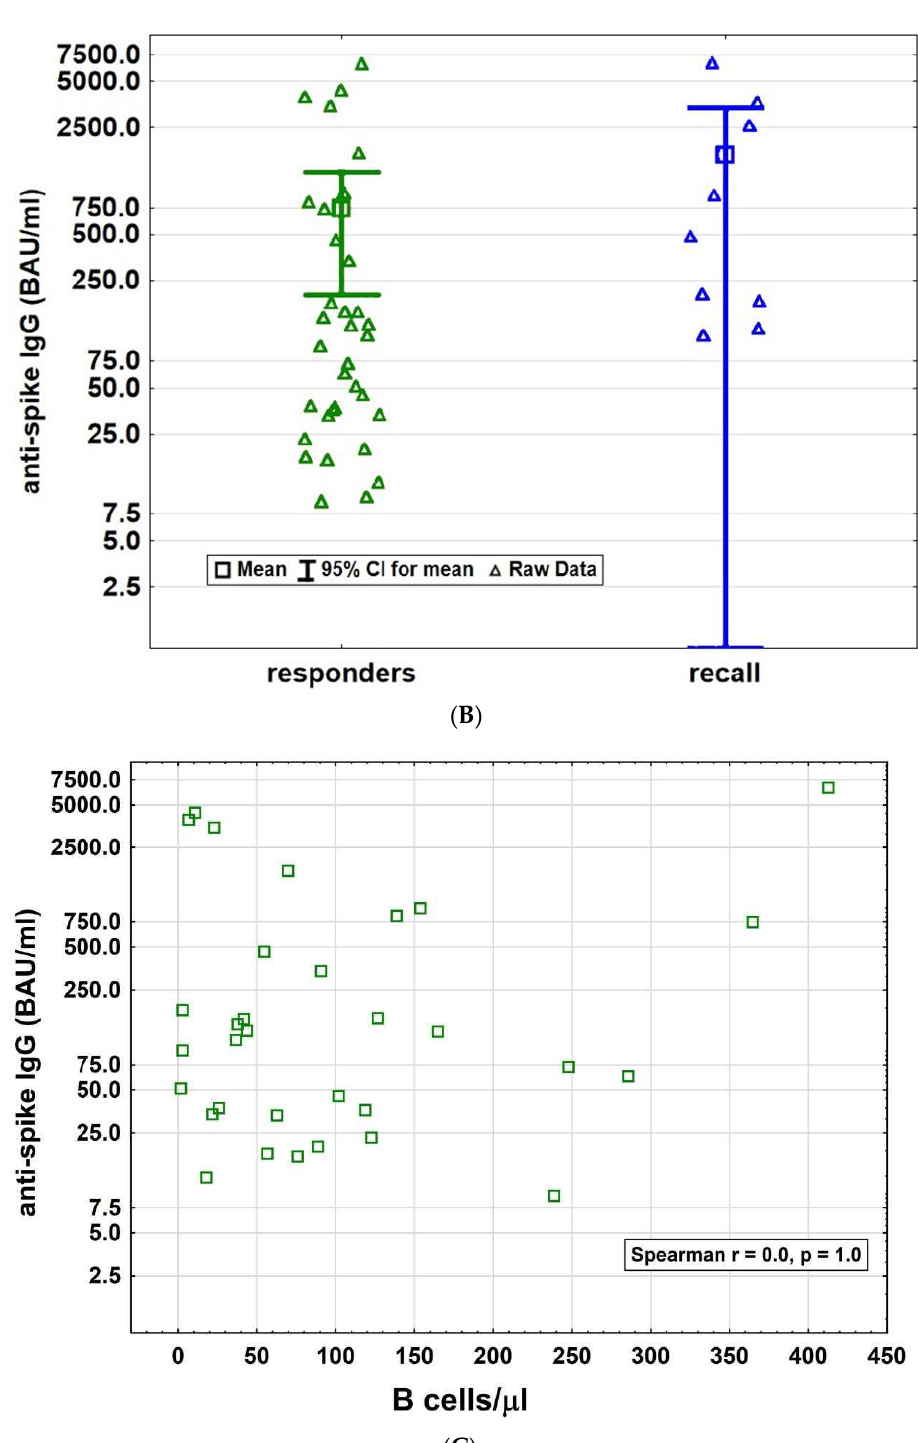
Figure 1. ( A ) Peripheral B-cell counts among all three patient groups at the time of anti-spike IgG assessment. B-cell numbers are highest in the responder cohort compared to the non-responders and the recall cohort. B cells among the non-responders and among the recall cohort were not statistically different. ( B ) Humoral response to SARS-CoV-2 antigens in terms of anti-spike IgG antibody levels were similar among the responder and recall cohort. ( C ) We found no correlation between B-cell counts and amount of anti-spike IgG levels among the responders. BAU = binding antibody units; CI = confidence interval; IgG = Immunoglobulin G; * = statistically significant.